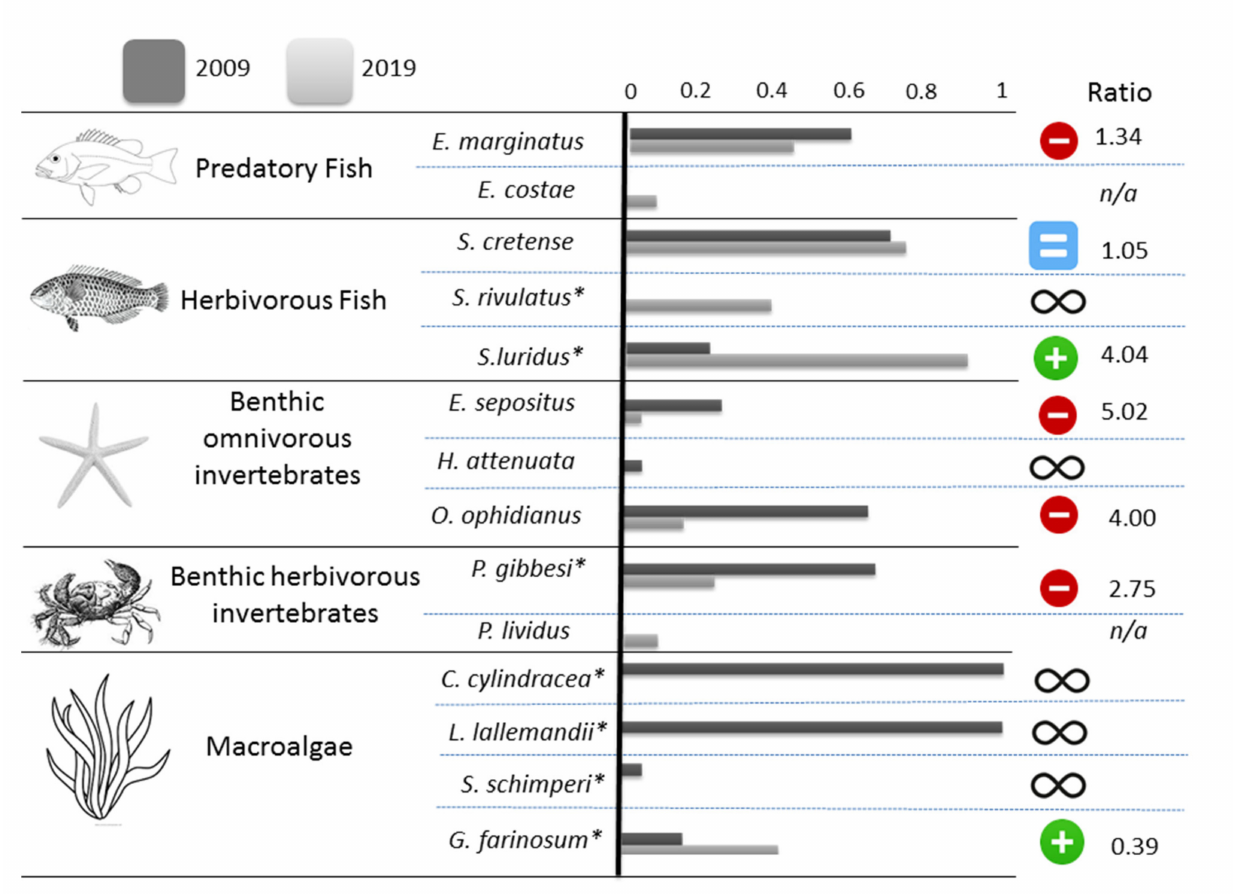
Figure 2. Species occupancy (model-averaged values) and the ratio between 2009 and 2019 occupancy values. n/a indicates species that were not examined during 2009 survey; asterisk (*) denotes alien species; the plus sign indicates an increase of occupancy and the minus sign a decrease (as indicated by the best model); the equals sign indicates no change while the infinity sign denotes infinite change due to a new invasion (i.e., S. rivulatus ) or an extinction ( C. cylindracea , L. lallemandii , S. schimperi